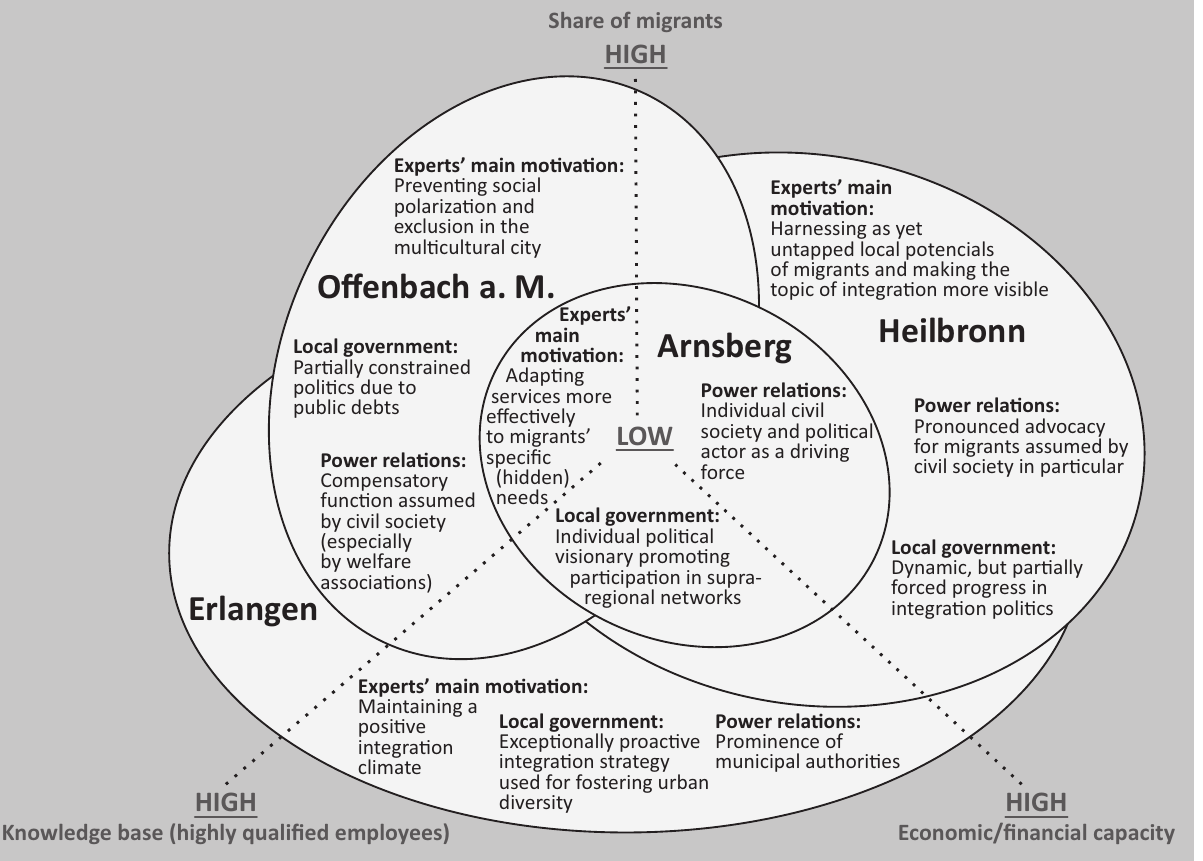
Figure 3. Synopsis of city-specific discourses and their relation to city characteristics. Note: For detailed information on structural data see Figure